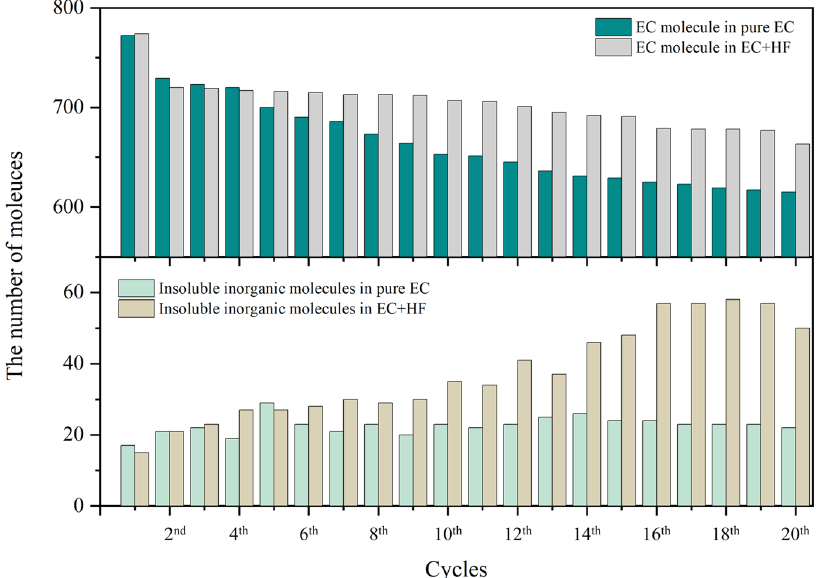
Fig. 9 Chemical decomposition and synthesis of electrolyte components upon charging/discharging cycles in both pure EC and EC + HF electrolyte systems. Upper chart shows the chemical decomposition of organic EC molecules. Lower chart shows the synthesis of insoluble inorganic